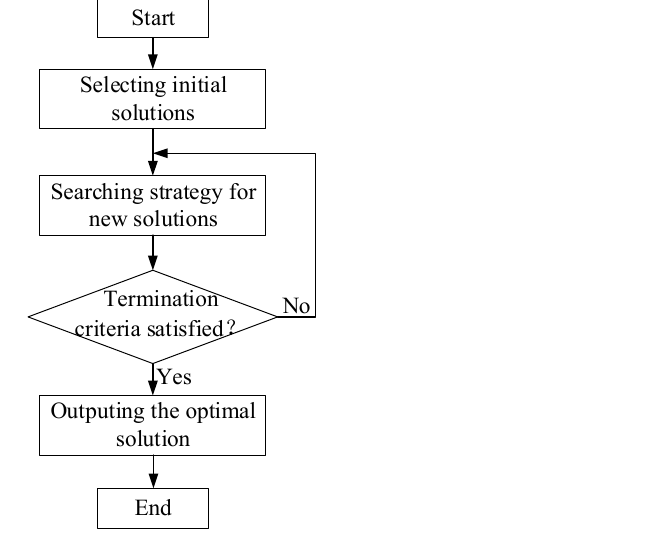
Figure 2. General working mechanism of optimization algorithms.